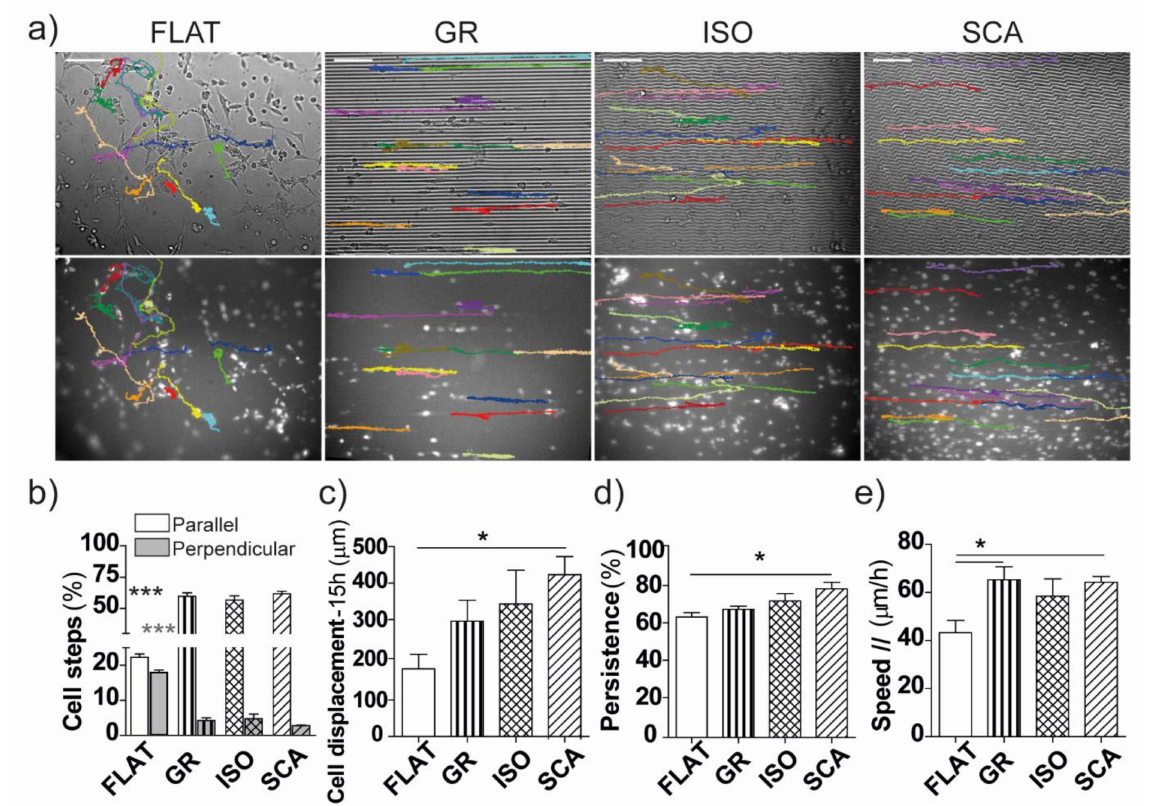
Figure 5. Single cell migration. ( a ) Representative bright-field images of the RT4-SC migration patterns (colored tracks) on FLAT, GR, ISO and SCA, in the bright field (first row) and in GFP-fluorescence (second row). The migration was followed by time-lapse microscopy for 20 h; scale bar = 100 µ m. ( b – e ) Single cell migration analysis (data = mean ± SEM, n ≥ 3): ( b ) percentage of steps parallel ( ± 15 ◦ in respect to the pattern’s main direction; white columns) and perpendicular ( ± 75–105 ◦ to the pattern’s main direction; grey columns) to the pattern’s orientation for each substrate: *** p < 0.001 FLAT vs. all micropatterns, one-way ANOVA, Bonferroni’s test. ( c ) The final cell displacement (at t = 15 h) from the t = 0 position, on different substrates: * p < 0.05 SCA vs. FLAT, one-way ANOVA, Bonferroni’s test. ( d ) Persistence: the percentage of parallel steps in the same direction of migration: * p < 0.05 SCA vs. FLAT, one-way ANOVA. Bonferroni’s test. ( e ) The average cell speed ( µ m/h) in the parallel direction ( ± 15 ◦ in respect to pattern’s main direction): * p < 0.05 vs. FLAT, one-way ANOVA, Bonferroni’s